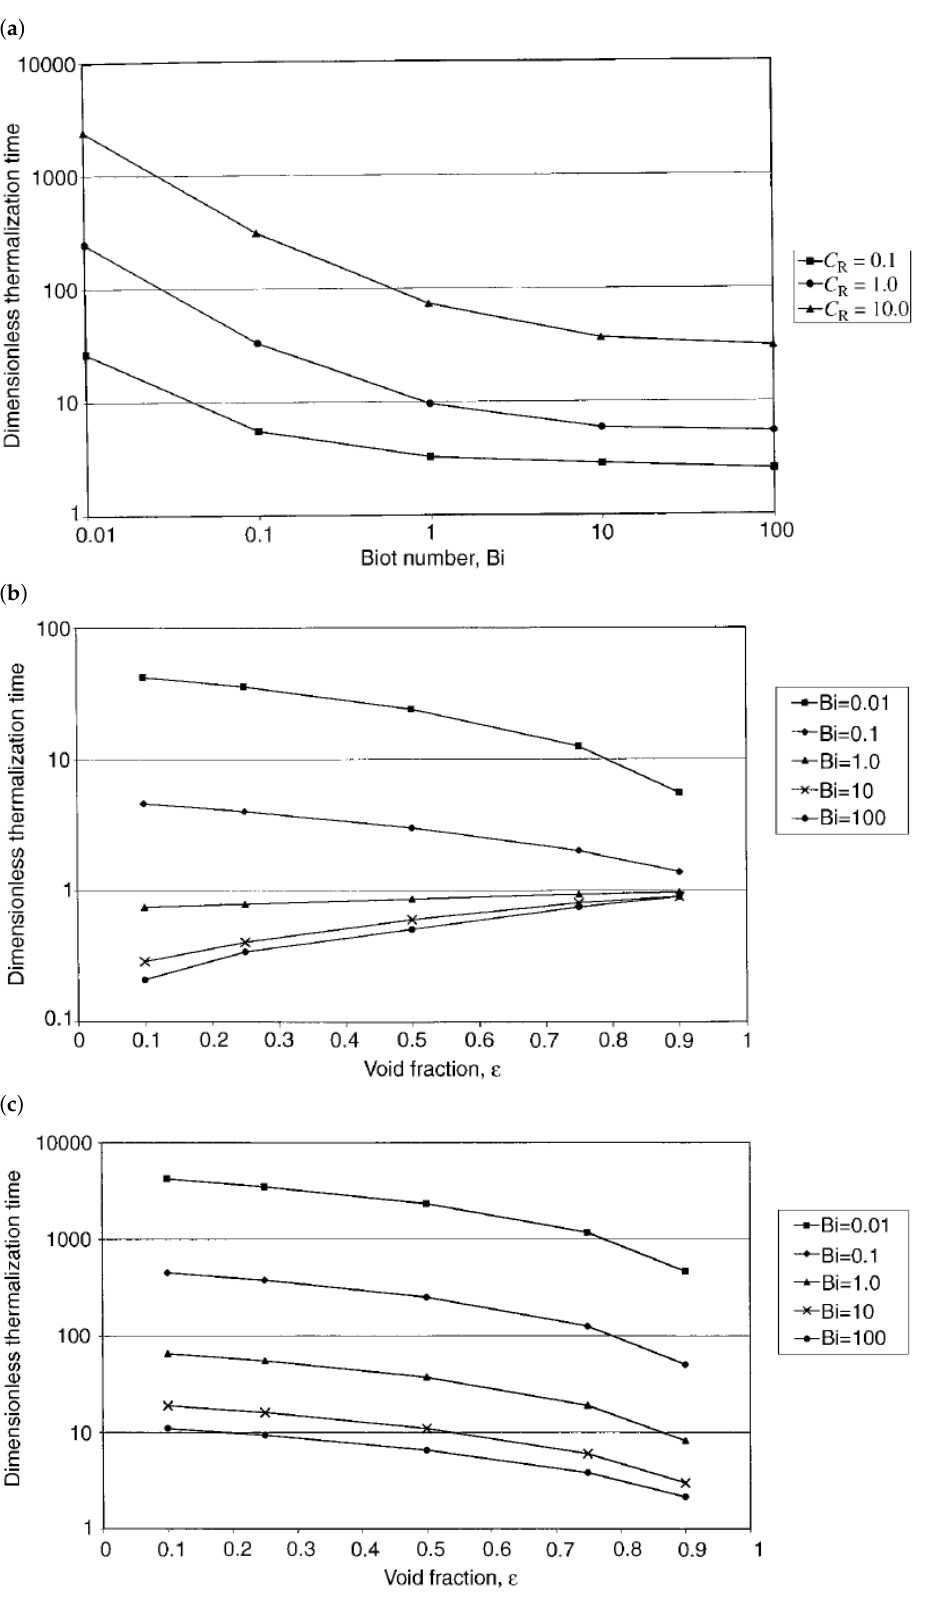
Figure 21. Effects of some controlling parameters on ( η tt ), ( a ) effects of Bi and C R at ε = 0.5, ( b ) effects of ε and Bi at C R = 0.1, ( c ) effects of ε and Bi at C R = 10, reported by Al-Nimr and Abu-Hijleh